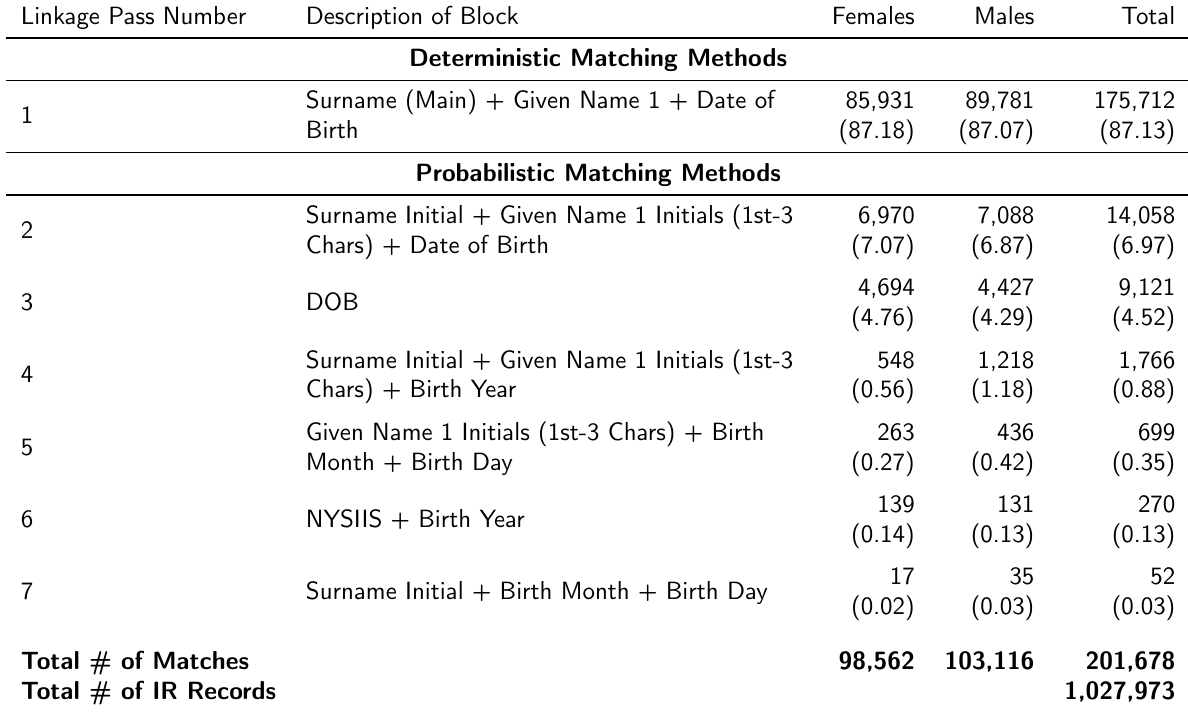
Table 1: Results of IR Linkage to the RPDB, using Deterministic and Probabilistic Matching Methods, Number (percent of total linked records).